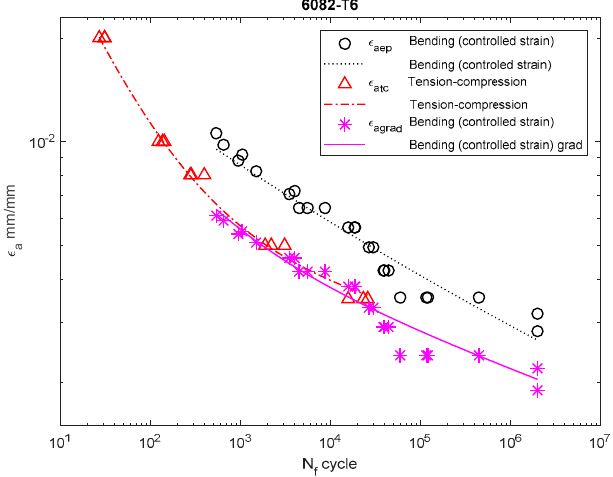
Figure 12. Dependency chart for the strain amplitude ε a = f ( N f ) for 6082-T4 steel.